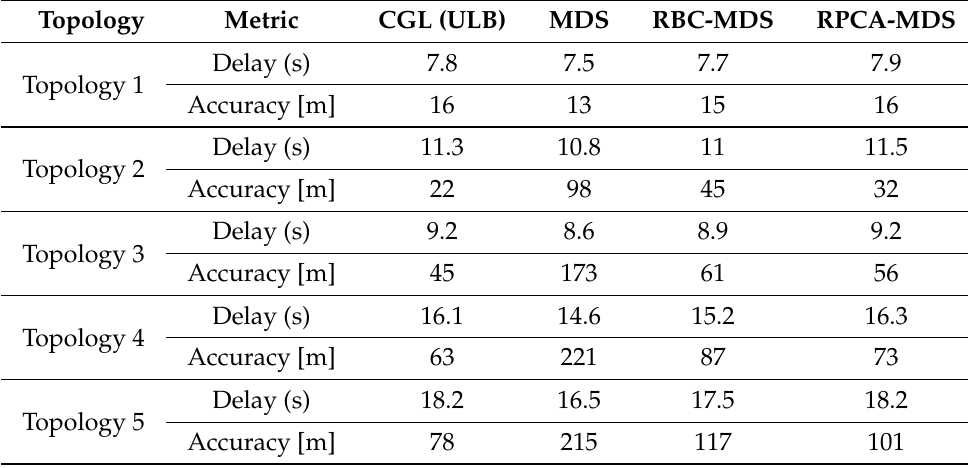
Table 3. Sea experiment results for playback data from [38]. Five topologies are